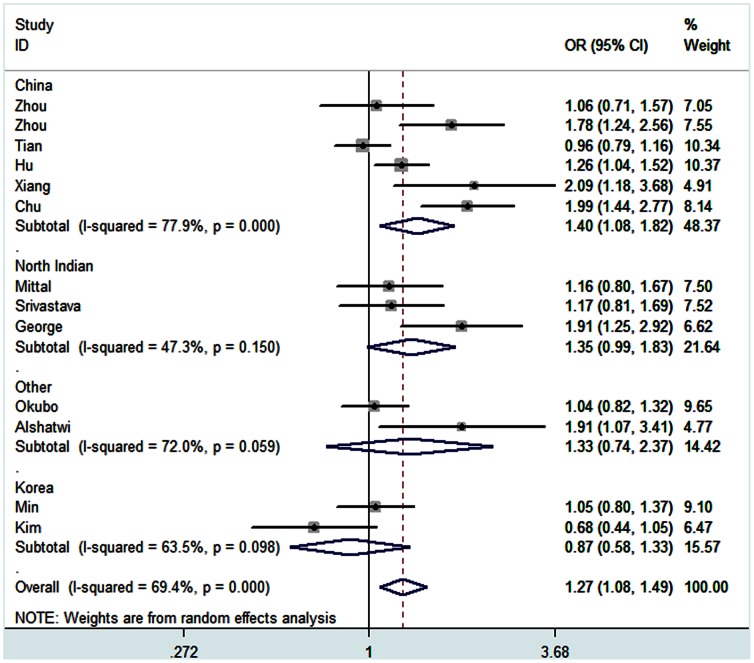
Forest plots of effect estimates for rs3746444 stratified by country (GG+GA vs AA).For each studies, the estimate of OR and its 95% CI is plotted with a box and a horizontal line. Filled diamond pooled OR and its 95% CI.